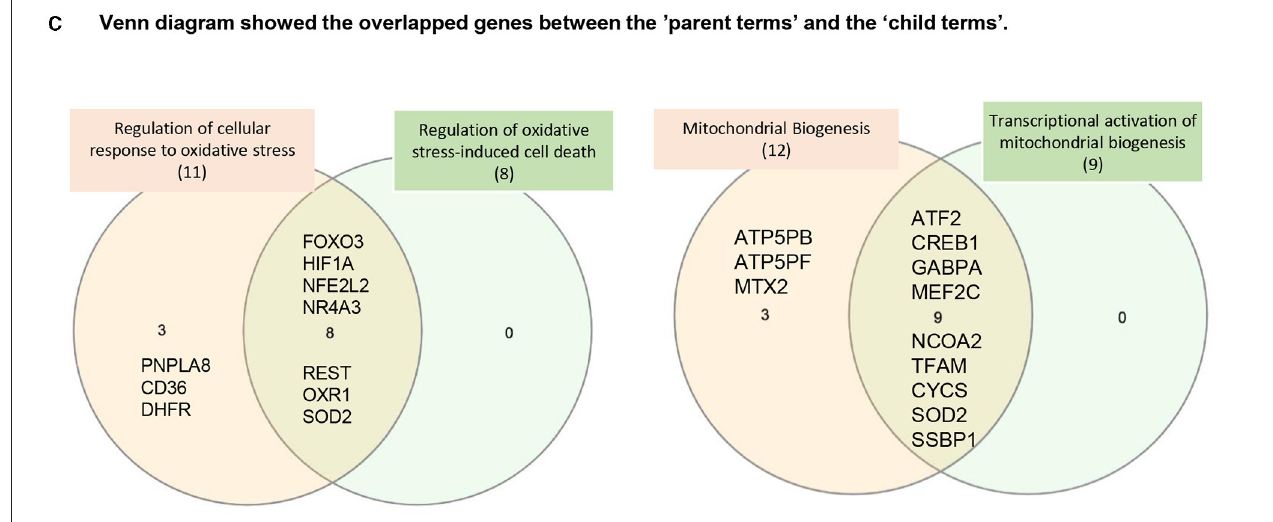
FIGURE 10 | Network data integration database Cytoscape analysis (https://cytoscape.org/) was performed to analyze the network connection among 172 upregulated LPI TFs, LPI-increased mitocarta genes, and LPI-upregulated ROS regulators. (A) Ontology network among LPI-upregulated TFs, mitoCarta genes, and ROS regulators. The cluster of 172 LPI-increased TFs is shown in red, the cluster of 152 LPI-upregulated mitoCarta genes is shown in blue, and the cluster of 18 LPI-elevated ROS regulators is shown in purple. One node represents a term/pathway, and the node size stands for significance. The bigger the node size, the higher the significance. (the smallest node in this figure is p < 0.05). The proportion of the colors in each node indicates the percentage of genes that contribute to this term/pathway from each cluster. The red arrow highlights five terms/pathways, indicating that the three clusters of genes equally contribute to a term/pathway. We focus on these five pathways, and the other 25 shown in this figure are closely related to the five. The gray lines indicate the connection between each term. The thicker the line, the stronger the correlation. The gray arrow starts from “parent term” to “child term.” The child term is more specialized than its parent term. (B) Detailed data distribution for five terms/pathways. The associated genes% represent how many genes from our three clusters matched to the genes of terms in the database. The gene clusters #1, #2, #3 indicate how many percentages of each cluster of genes contribute to the term/pathway. (C) Venn diagram shows the overlapped genes between the “parent terms” and the “child